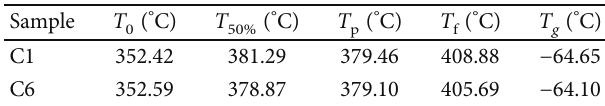
Figure 7: TGA curve of CNRL raw rubber fi lm samples. Table 7: Degradation temperature and T fi lm